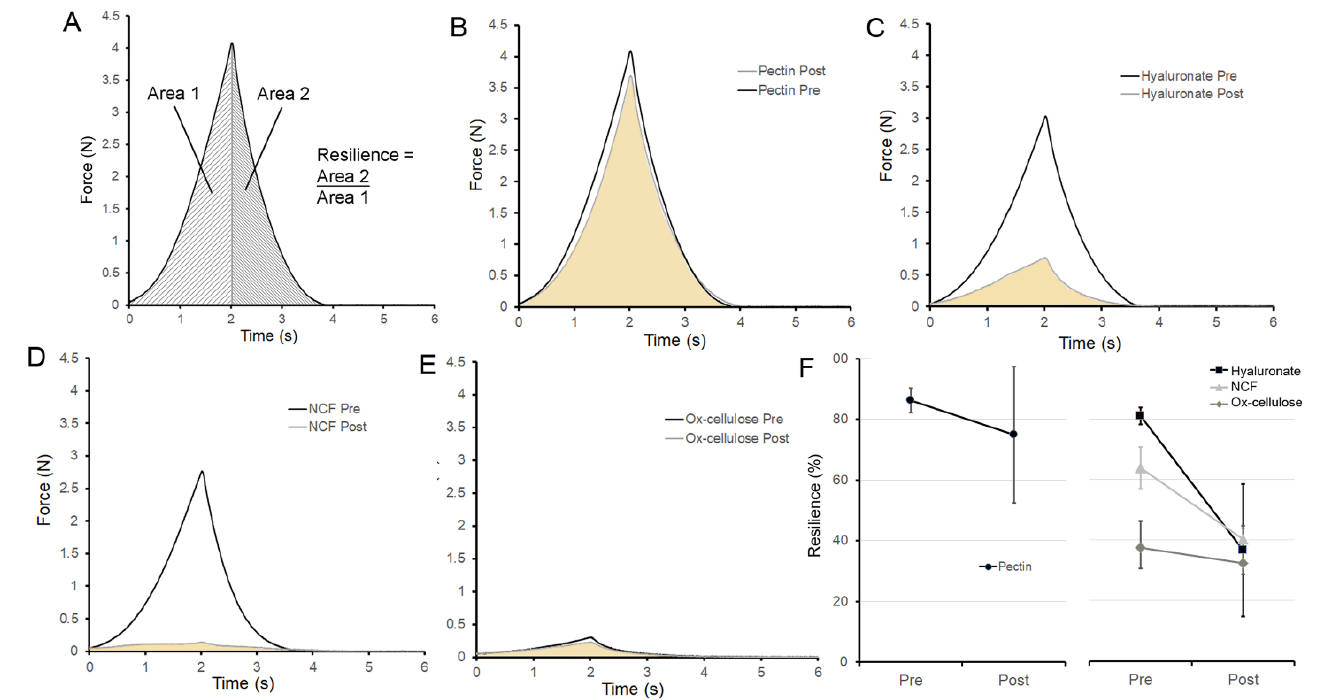
Figure 5. Resilience of pectin films before and after water-induced repair. ( A ) A 5 mm stainless steel sphere was used to probe the pectin films to a displacement of 1 mm. The resilience was calculated as the ratio between absorbed energy during elastic deformation (Area 1) and the released energy upon unloading (Area 2). ( B ) Characteristic resilience curve of pectin films is shown before (black) and after (gray) burst fracture and water-induced repair. Similar resilience curves are shown for sodium hyaluronate ( C ), NCF ( D ), and ox-cellulose ( E ). ( F ) Summary of resilience replicates (N = 10) is shown. Pectin resilience was significantly greater than the polymer controls ( p < 0.001). The mean ± 1 standard deviation (SD) is shown. The resilience mechanics were assessed at a water content of 8% ( w / w ).